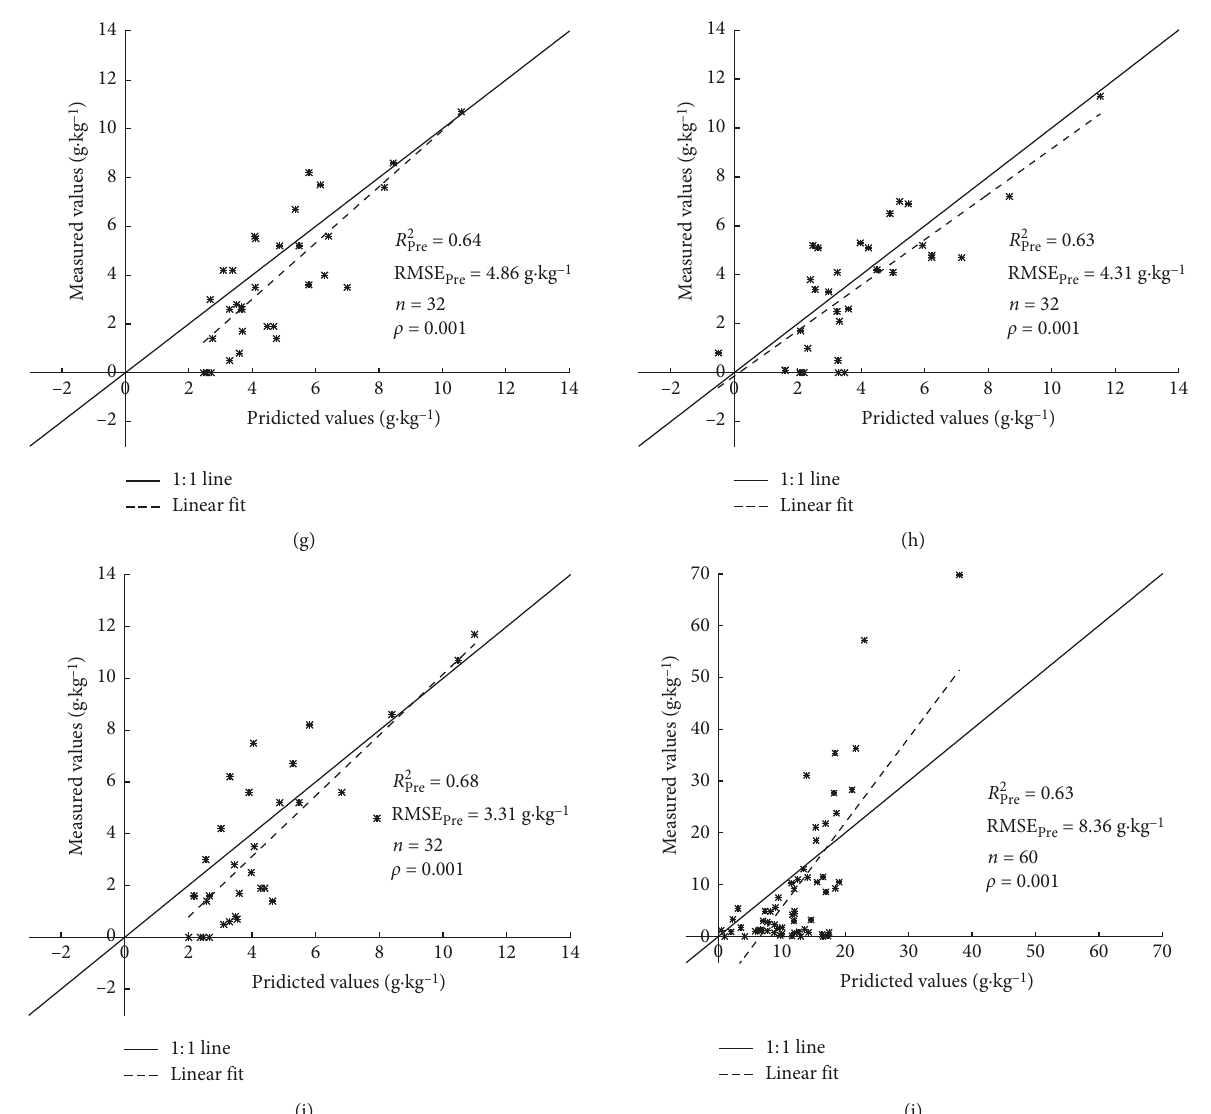
Figure 5: Scatter plots of predicted vs. measured SSC. (a) NDSI-Ebinur Lake Basin. (b) RSI-Ebinur Lake Basin. (c) Combination-Ebinur Lake Basin. (d) NDSI-Ugan-Kuqa Oasis. (e) RSI-Ugan-Kuqa Oasis. (f) Combination-Ugan-Kuqa Oasis. (g) NDSI-Keriya Oasis. (h) RSI- Keriya Oasis. (i) Combination-Keriya Oasis. (j) Global